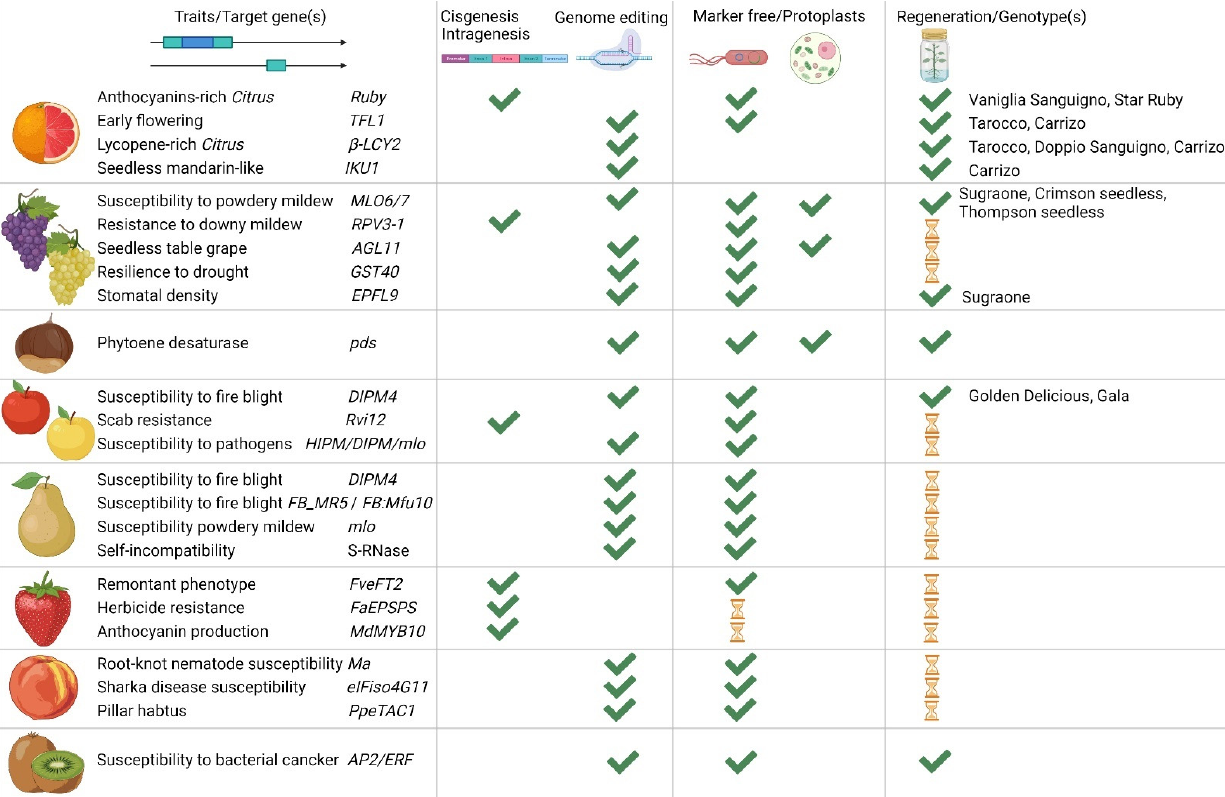
Figure 3. Summary of the main achievements reached by the Italian scientific community over the last years exploiting new genomic techniques (NGTs). From left to right, the species selected for genetic improvement, the gene(s) identified as target (for chestnut the selected gene was chosen as proof of concept), the technique exploited for the selected gene(s) (i.e., genome editing or cisgene- sis/intragenesis), and the selected approach (i.e., Agrobacterium -mediated marker free transformation or DNA-free through protoplasts transfection). In the last column, we highlight if improved plants were already regenerated, and which cultivars were regenerated (published data reported in the previous sections). The hourglass represents that work is in